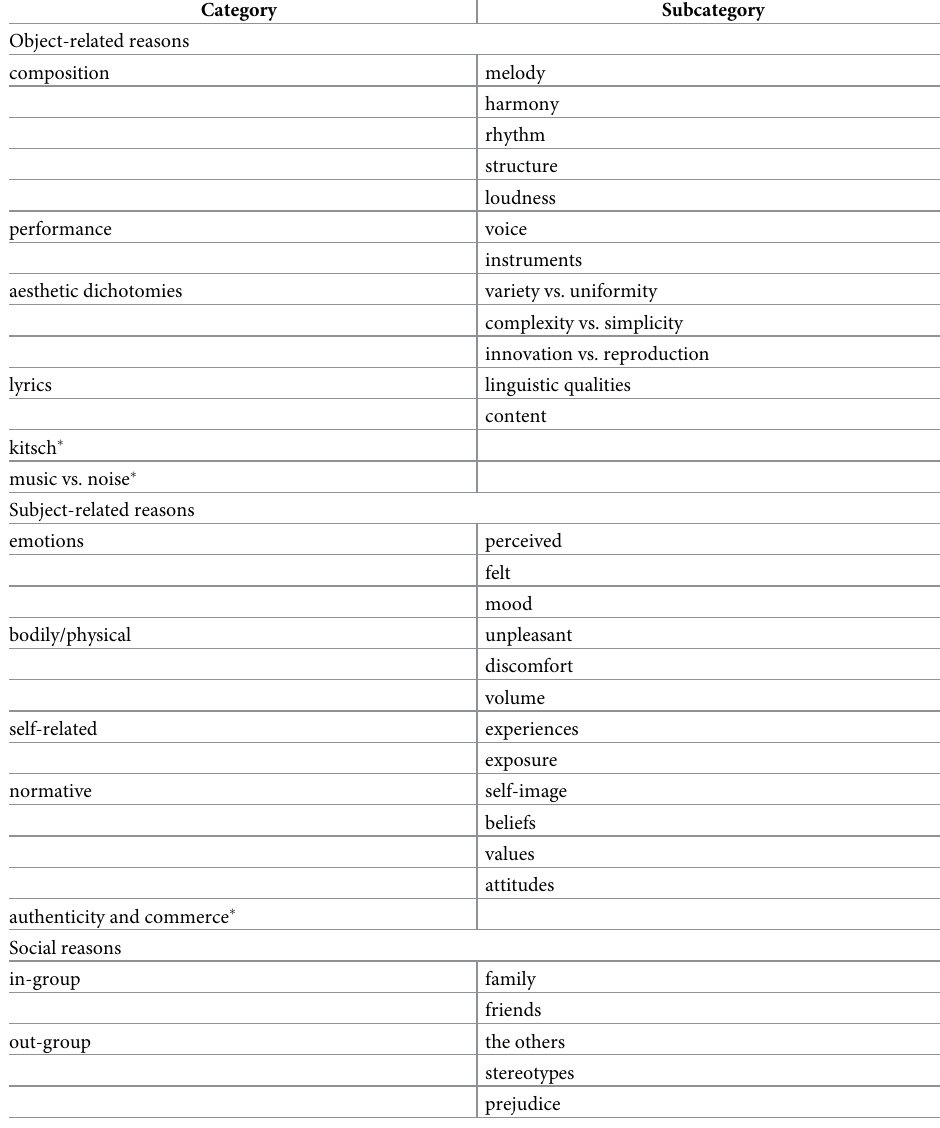
Table 1. Rationales for disliked